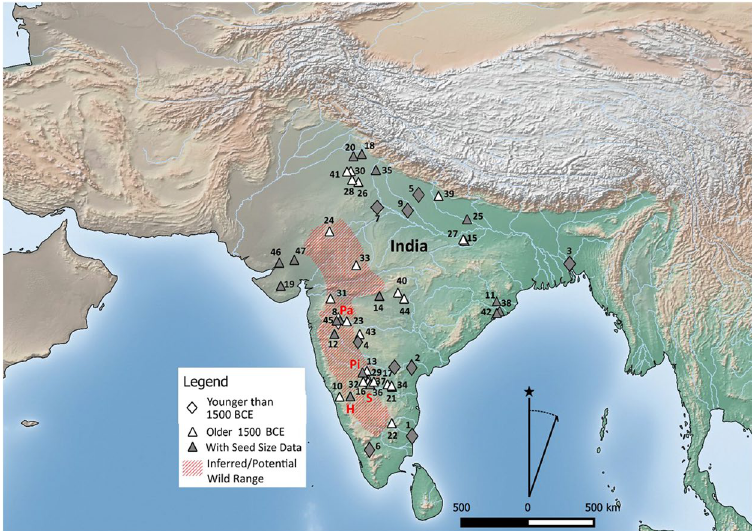
Figure 1. Map showing the distribution of early archaeological horsegram, indicating those sites included in the present study (Pa = Paithan, Pi = Piklihal, H = Hallur, S = Sanganakallu). Additional sites with horsegram recorded (1) Arikamedu (2) Veerapuram (3) Vikrampura Bangladesh (4) Ter (5) Saunphari (6) Perur (7) Noh (8) Nevasa (9) Ahirua Rajarampur (10) Brahmagiri (11) Ostapur (12) Inamgaon (13) Watgal (14) Tuljapur Garhi (15) Tokwa (16) Tekkalakota (17) Singanapalle (18) Sanghol (19) Rojdi (20) Rohira (21) Peddamudiyam (22) Paiyampalli (23) Paithan (24) Ojiyana (25) Narhan (26) Mithathal (27) Malhar (28) Ludwala (29) Kurugodu (30) Kunal (31) Kaothe (32) Kadebakele (33) Kayatha (34) Iinjedu (35) Hulas (36) Hiregudda (37) Hattibelagallu (38) Harirajpur (39) Bhagimohari (41) Banawali (42) Golbai Sassan (43) Apegaon (44) Adam (45) Daimabad (46) Kanmer (47) Lotehswar. Also shown the predicted original wild range. Map created using QGIS Development Team, QGIS 2.12.3- Lyon 2015. QGIS Geographic Information System. Open Source Geospatial Foundation Project.